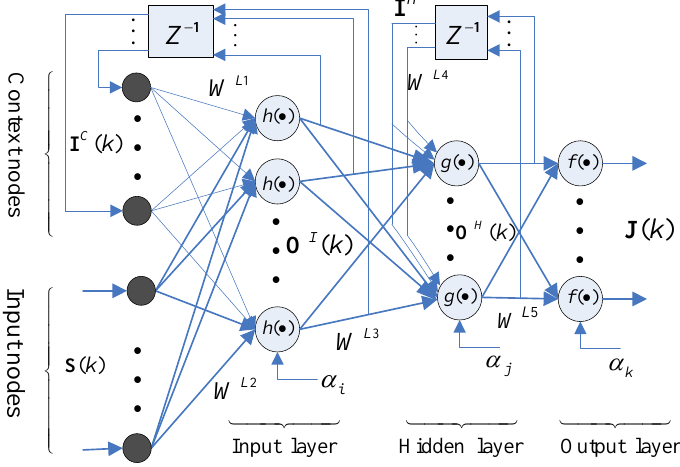
Figure 3. The framework of a feedback Elman neural network with its three layer